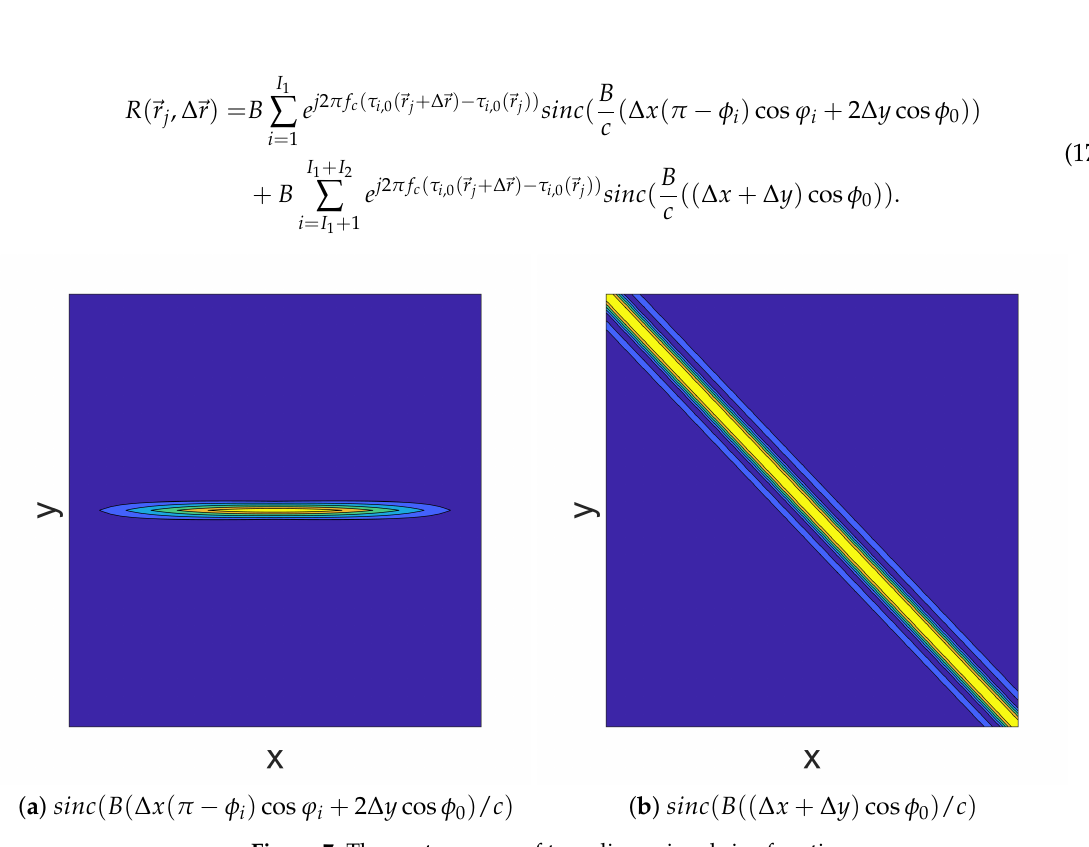
Figure 7. The contour map of two-dimensional sinc